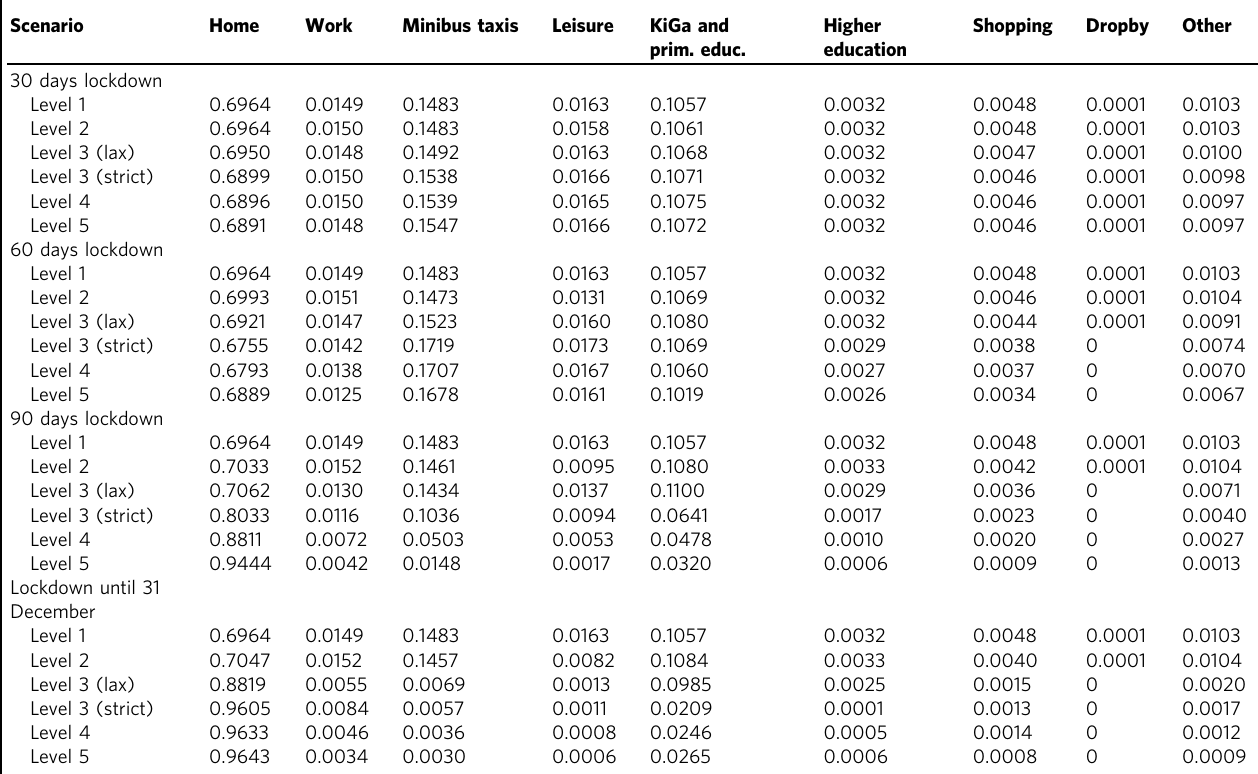
Table 6 Percentage of infection sites per lockdown level.